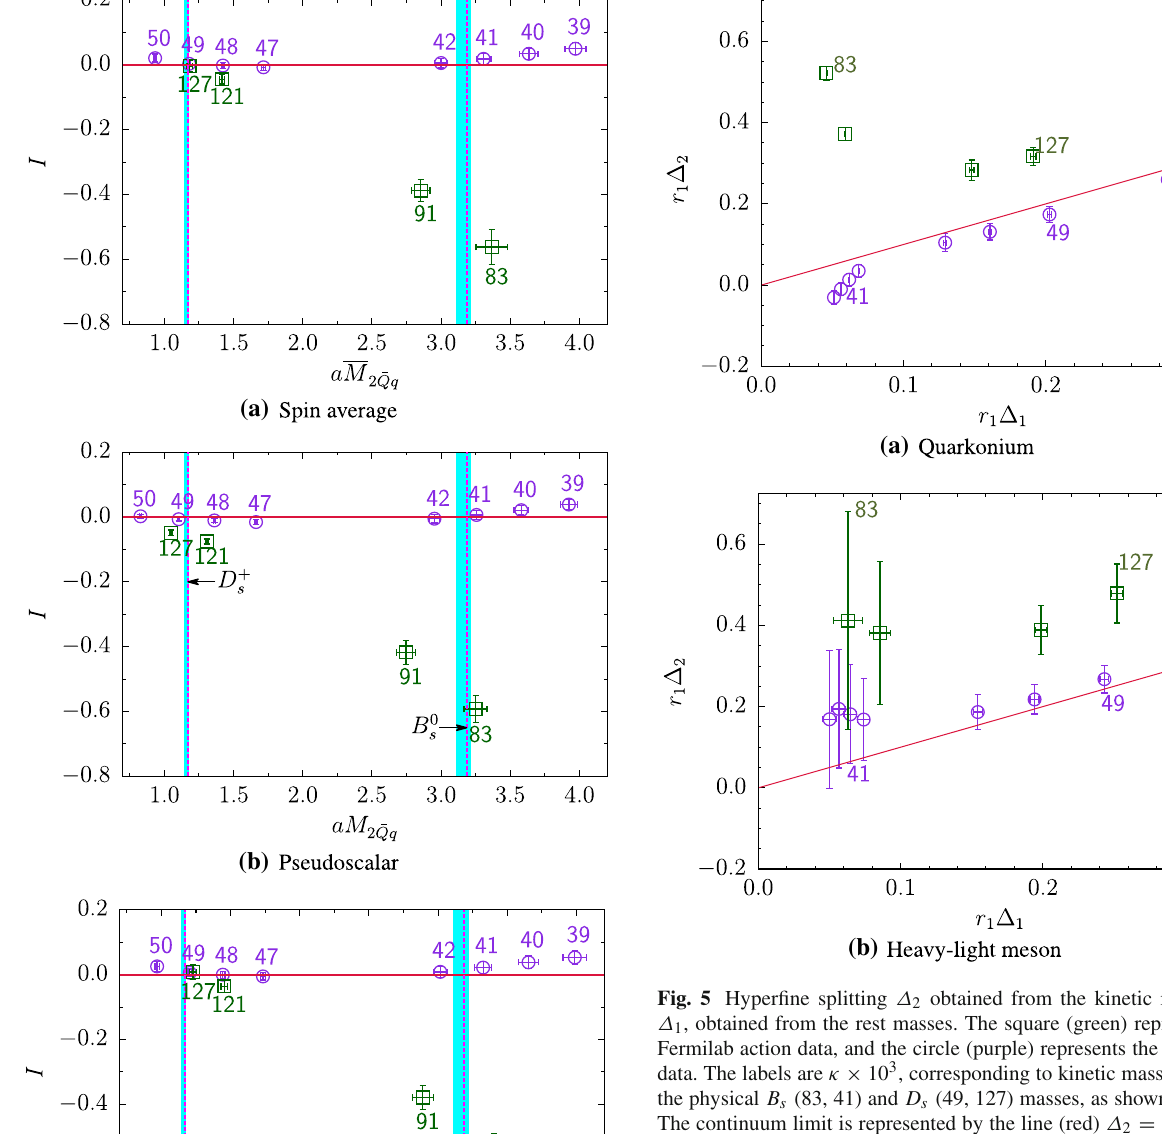
Fig. 4 Inconsistency I for a the spin-averaged mass M = 1 3 M ∗ ) , b pseudoscalar-meson mass, and c vector-meson mass. Data labels denote the value of κ × 10 3 . The purple circles (green squares) represents the OK (Fermilab) action. The errors are from the jack- knife. Vertical lines with bands represent the physical masses from the PDG [42] with experimental and (asymmetric) lattice-spacing errors added in quadrature. For the OK action I almost vanishes (cf. horizon- tal red line), but for the Fermilab action it does not